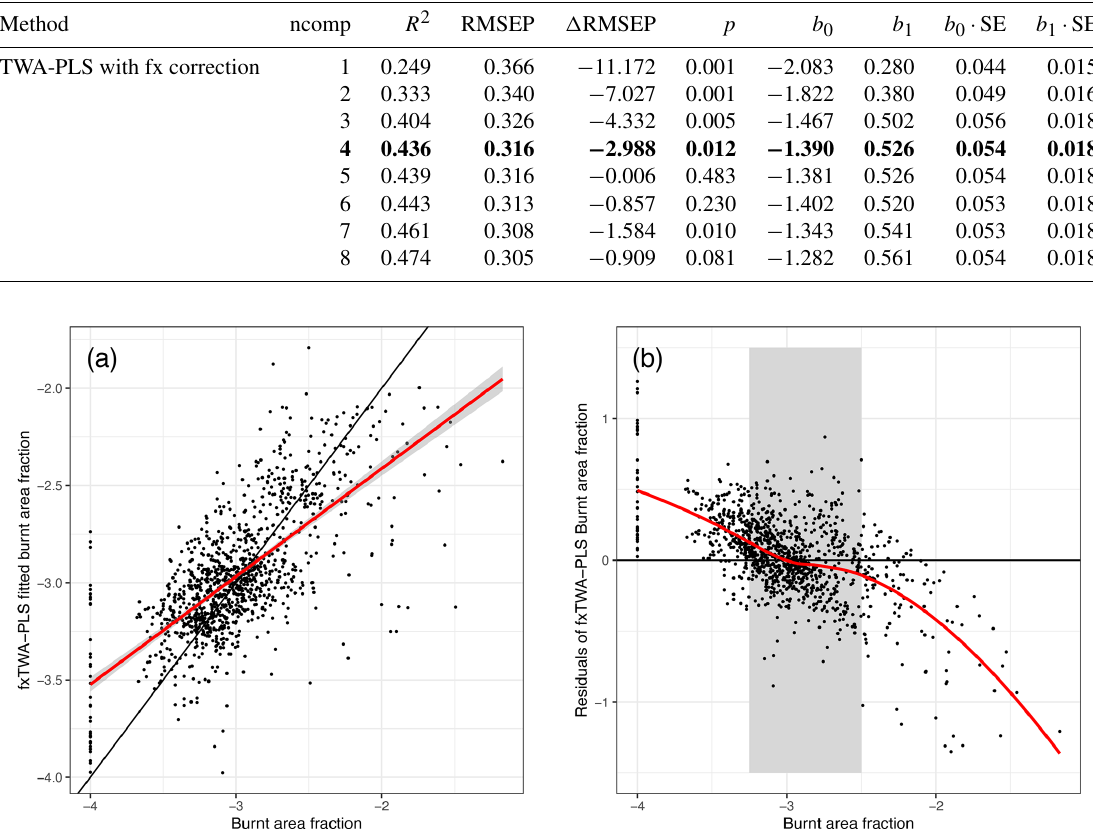
Figure 4. The fitted plot and residual plot of TWA-PLS method, with fx correction. Panel (a) is the reconstructed burnt area using the last significant number of components, which is four here. The x axis is the burnt area fraction derived from charcoal data, and the y axis is the burnt area fraction reconstructed from pollen data using TWA-PLS with fx correction. The 1 : 1 line is shown in black, and the linear regression line is shown in red to show the degree of overall compression. Panel (b) shows the residuals of reconstructed burnt area fraction using the last significant number of components. The x axis is the burnt area fraction derived from charcoal data, and the y axis is the residual of burnt area reconstruction using TWA-PLS with fx correction. The zero line is shown in black, and the locally estimated scatterplot smoothing is shown in red to show the degree of local compression. The low compression zone is shown by grey